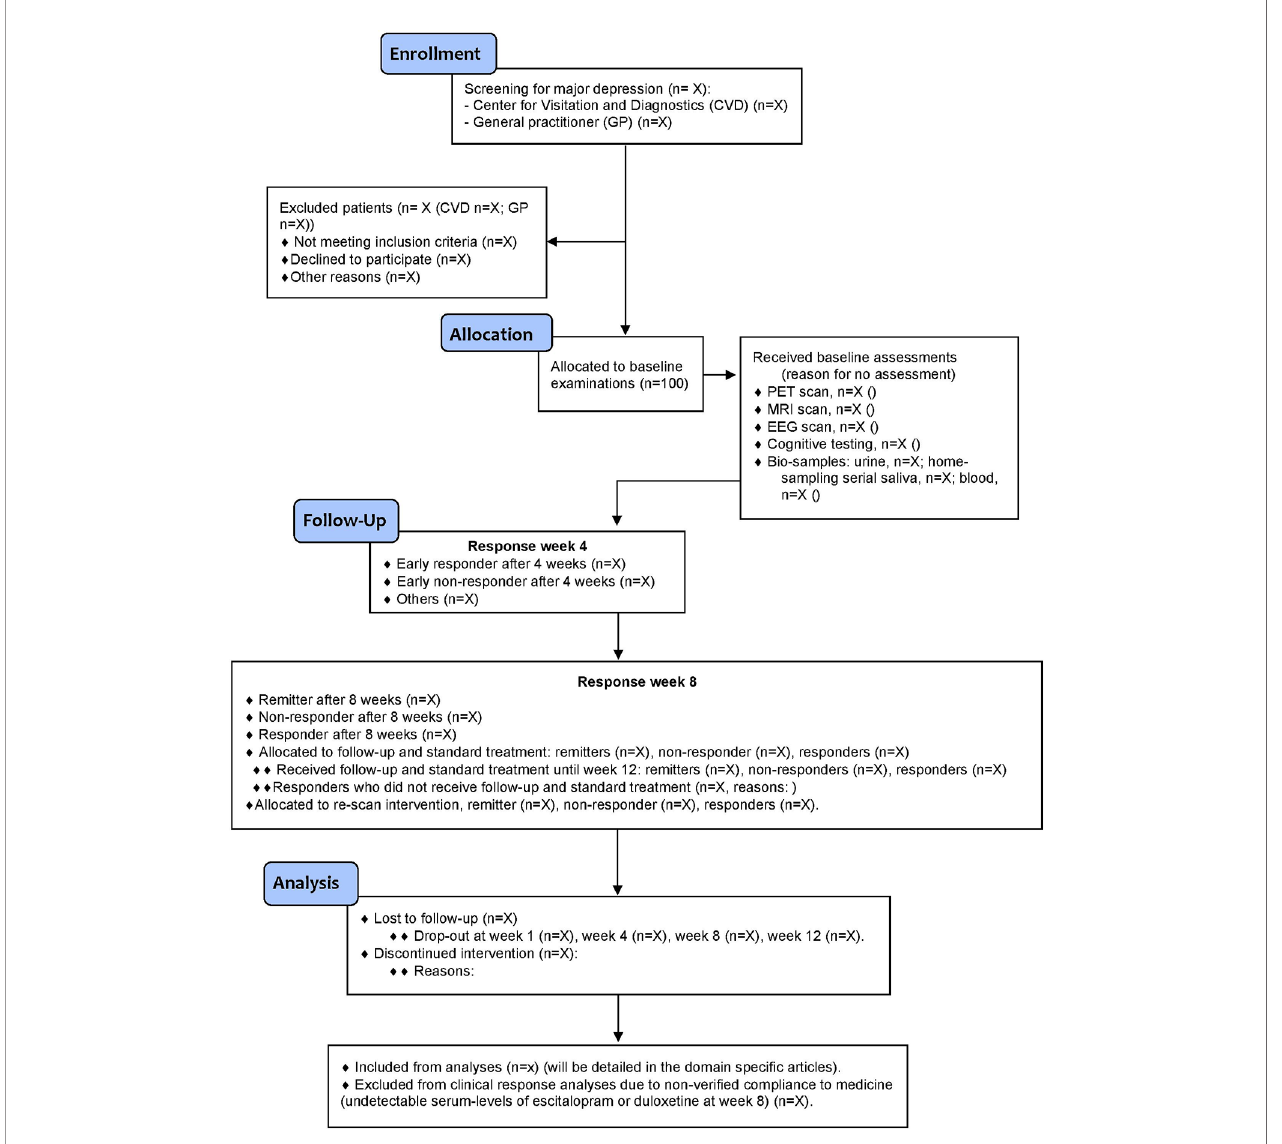
FIGURE 2 | Flow diagram (CONSORT) of the NeuroPharm